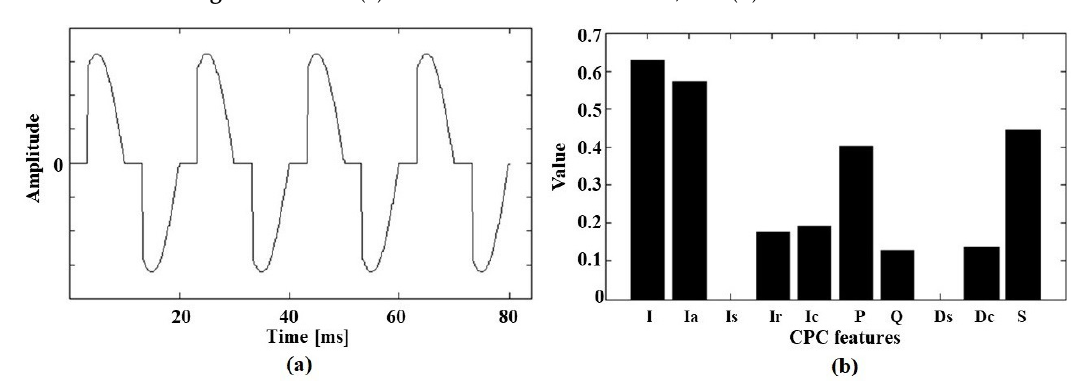
Figure 8. Dimmer with excitation angle of 60 ◦ : ( a ) simulated current waveform; and ( b ) CPC features.